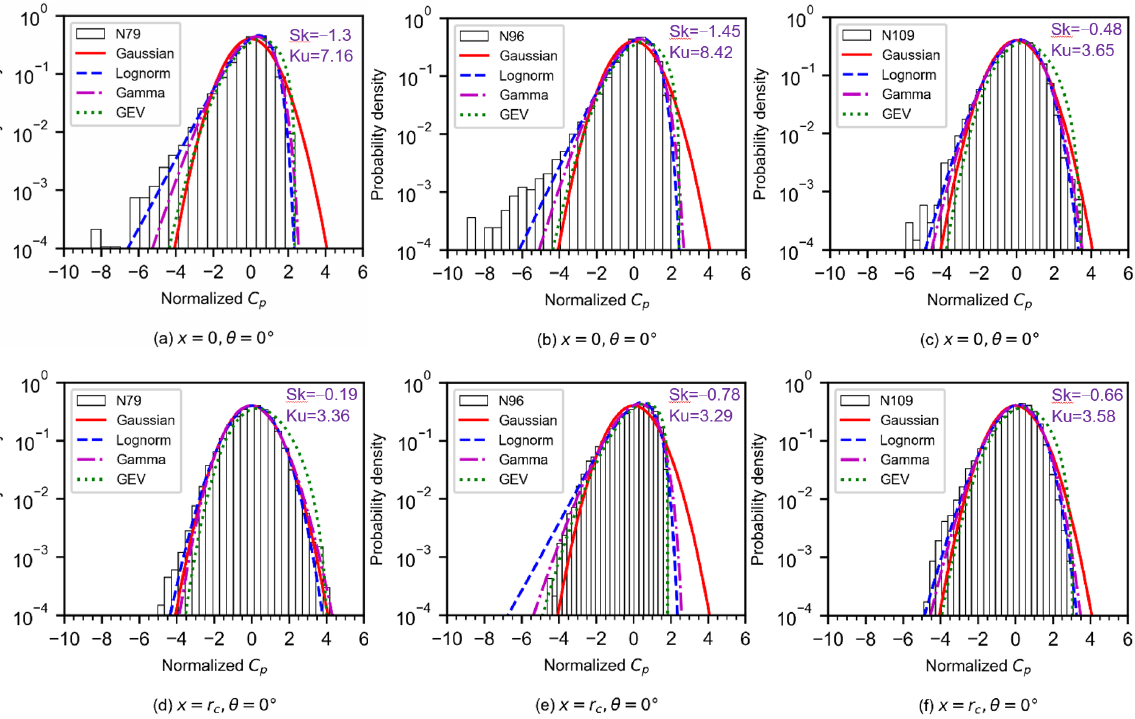
Figure 14. Probability density distribution of normalized pressure coe ffi cients at certain taps. ( a ) N79 at x = 0 and θ = 0 ◦ ; ( b ) N96 at x = 0 and θ = 0 ◦ ; ( c ) N109 at x = 0 and θ = 0 ◦ ; ( d ) N79 at x = r c and θ = 0 ◦ ; ( e ) N96 at x = r c and θ = 0 ◦ ; and ( f ) N109 at x = r c and θ = 0 ◦